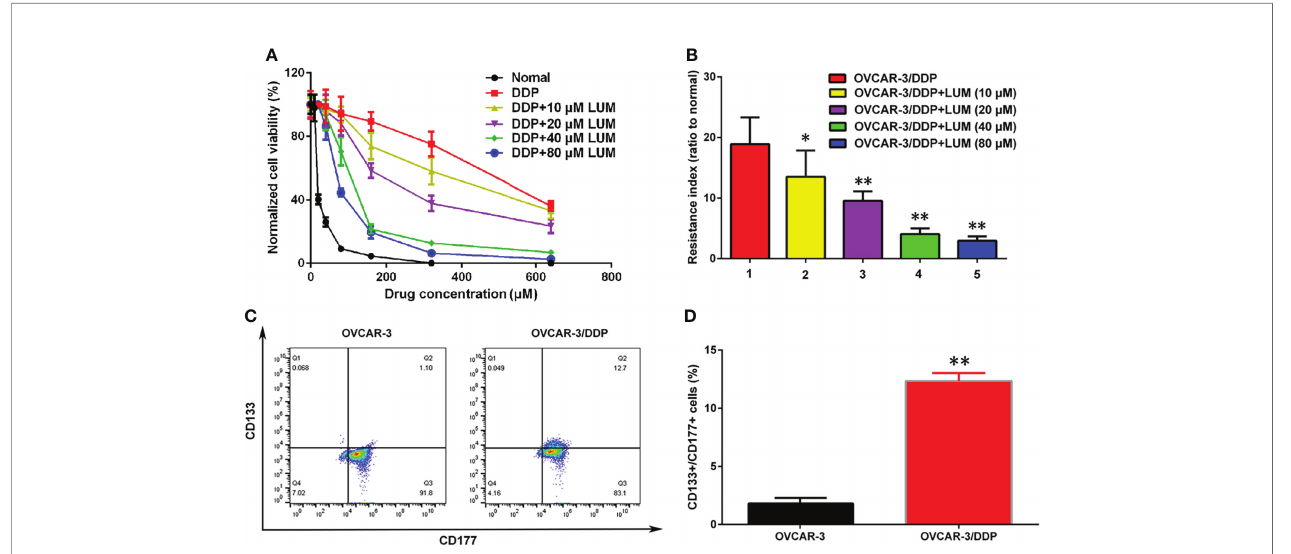
FIGURE 2 | Lumi fl avin treatment reduces the development of DDP resistance of ovarian cancer OVCAR-3 cells line that is associated with cancer stem cells (CSCs). DDP resistance of ovarian cancer OVCAR-3 cell lines were induced by gradient concentration increment method (26), and treated with 10, 20, 40, and 80 m m lumi fl avin intervention simultaneously. The cell inhibition rate and resistance index of OVCAR-3cells to DDP were detected by CCK-8 assay kit. The proportion of CSCs (CD133+/CD177+ double positive cells) in OVCAR-3 cells was detected by fl ow cytometry. (A) Inhibitory curves of lumi fl avin and DDP on OVCAR-3 and OVCAR-3/DDP cells. (B) Resistance index of OVCAR-3/DDP cells compared with OVCAR-3 cells. (C) Flow detection results of CD133+/CD117+ cells ratio of OVCAR-3 and OVCAR-3/DDP cells. (D) Statistical analysis graph of (C) . Mean ± SD ( n = 3). ** P < 0.01 difference between groups; * P < 0.05 difference between groups. DDP, cisplatin; OVCAR-3/DDP, DDP resistant OVCAR-3 cell lines; LUM, lumi fl